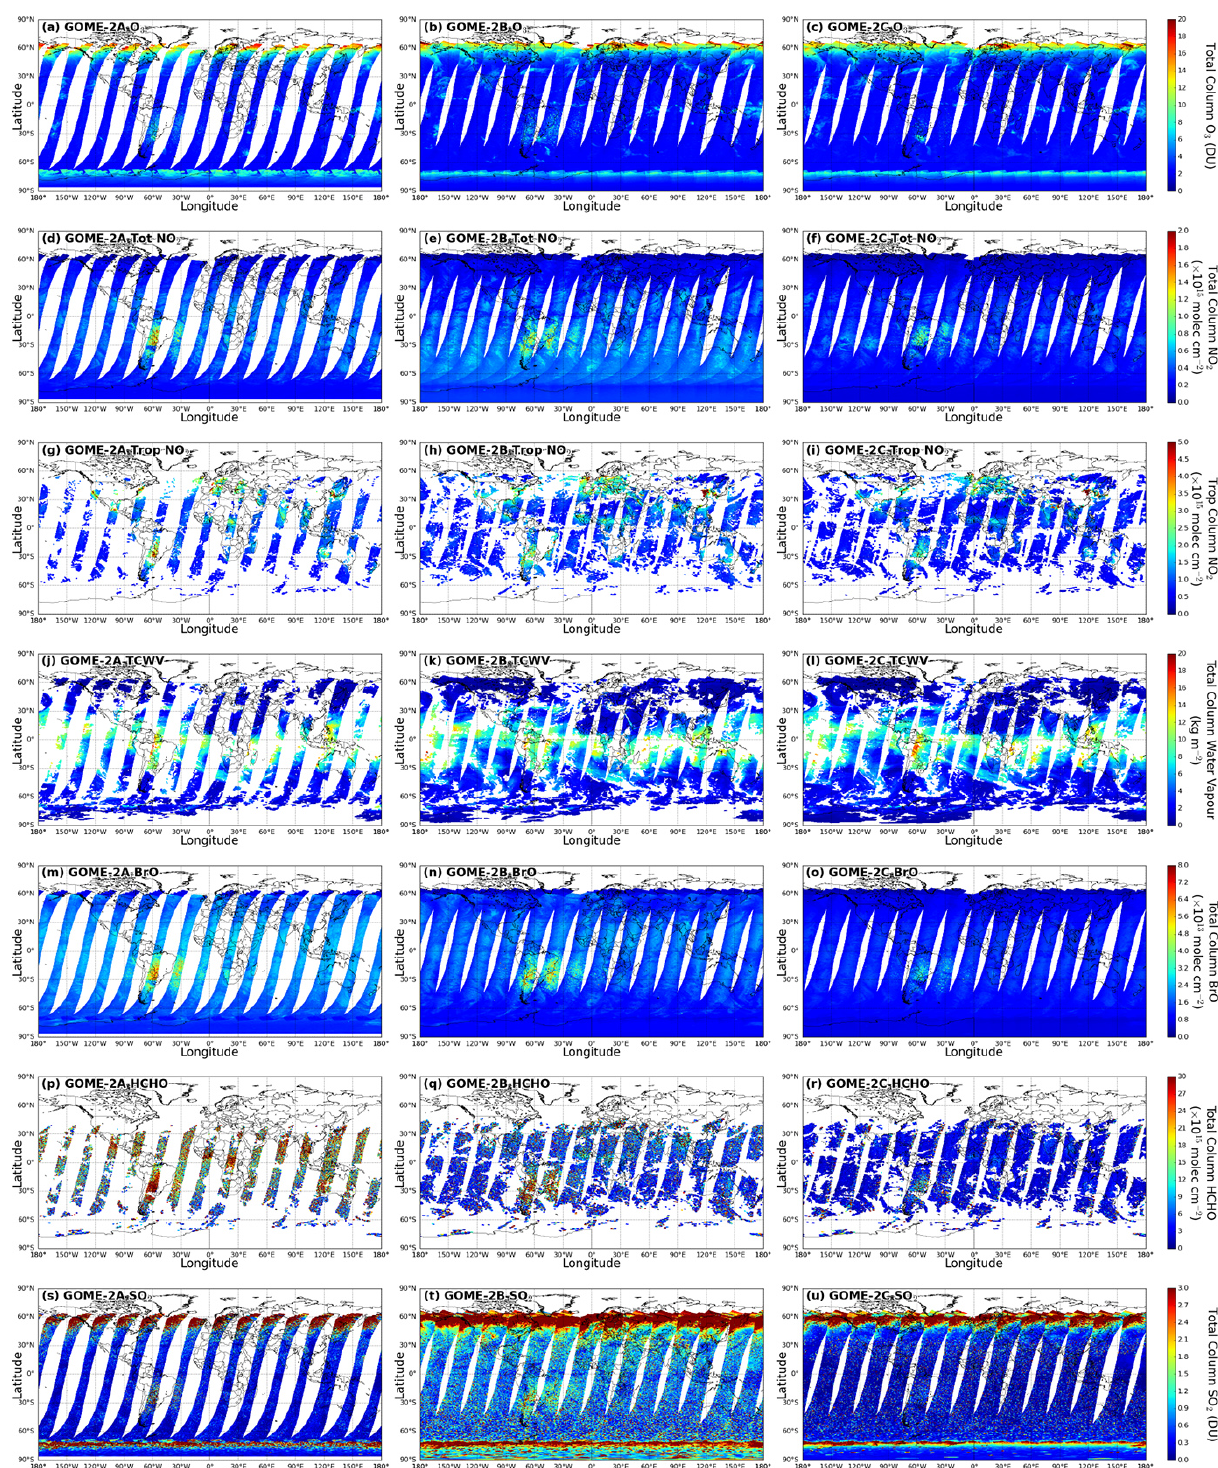
Figure 6. Derived measurement errors in the daily level-3 product of GOME-2A (first column), GOME-2B (second column), and GOME-2C (third column) for 15 January 2020. Measurement errors of total column O 3 (first row), total column NO 2 (second row), tropospheric column NO 2 (third row), total column water vapour (fourth row), total column BrO (fifth row), total column HCHO (sixth row), and total column SO 2 (seventh row) are